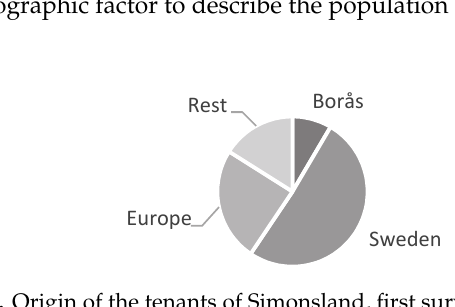
Figure A3. Origin of the tenants of Simonsland, first survey (106 individuals).